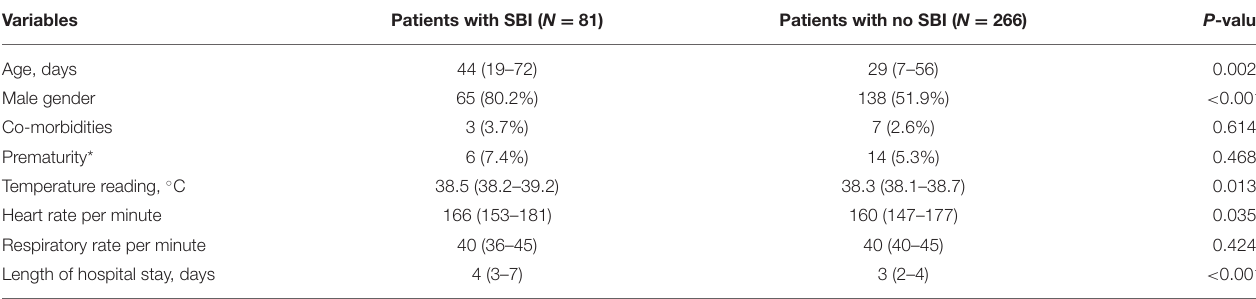
TABLE 1 | Baseline demographics, clinical characteristics and outcomes of study